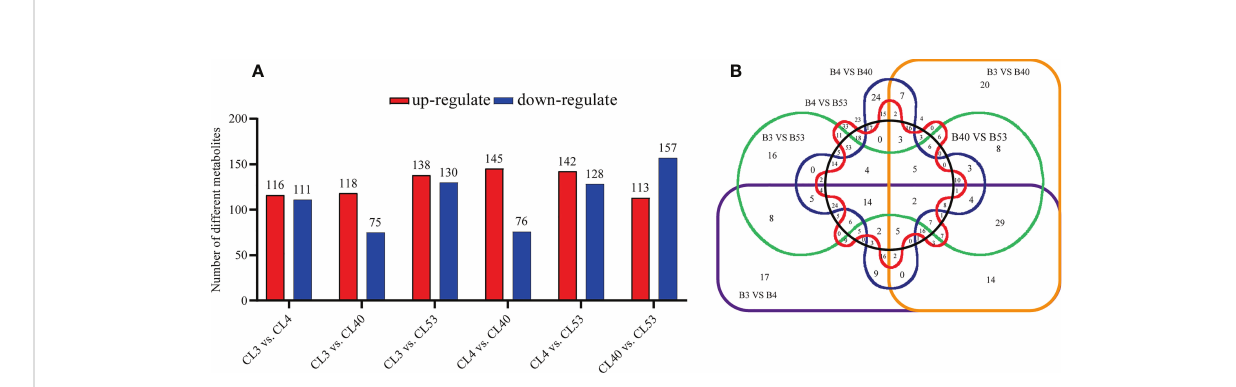
FIGURE 4 Comparative analysis of tissue-enrichaed and differentially metabolites. (A) Histogram showing the distribution of different metabolites between varieties. (B) Venn diagram showing the metabolites in buds compared to varieties.